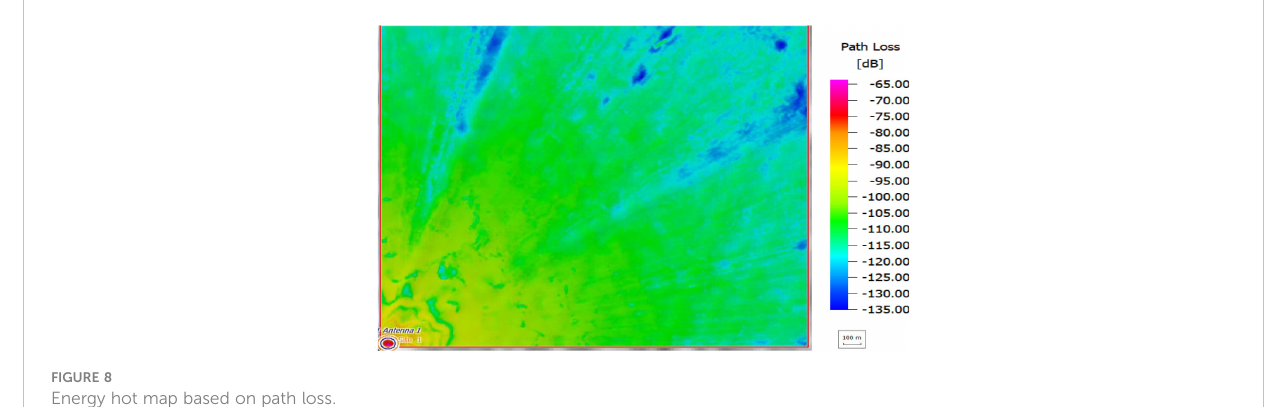
FIGURE 8 Energy hot map based on path